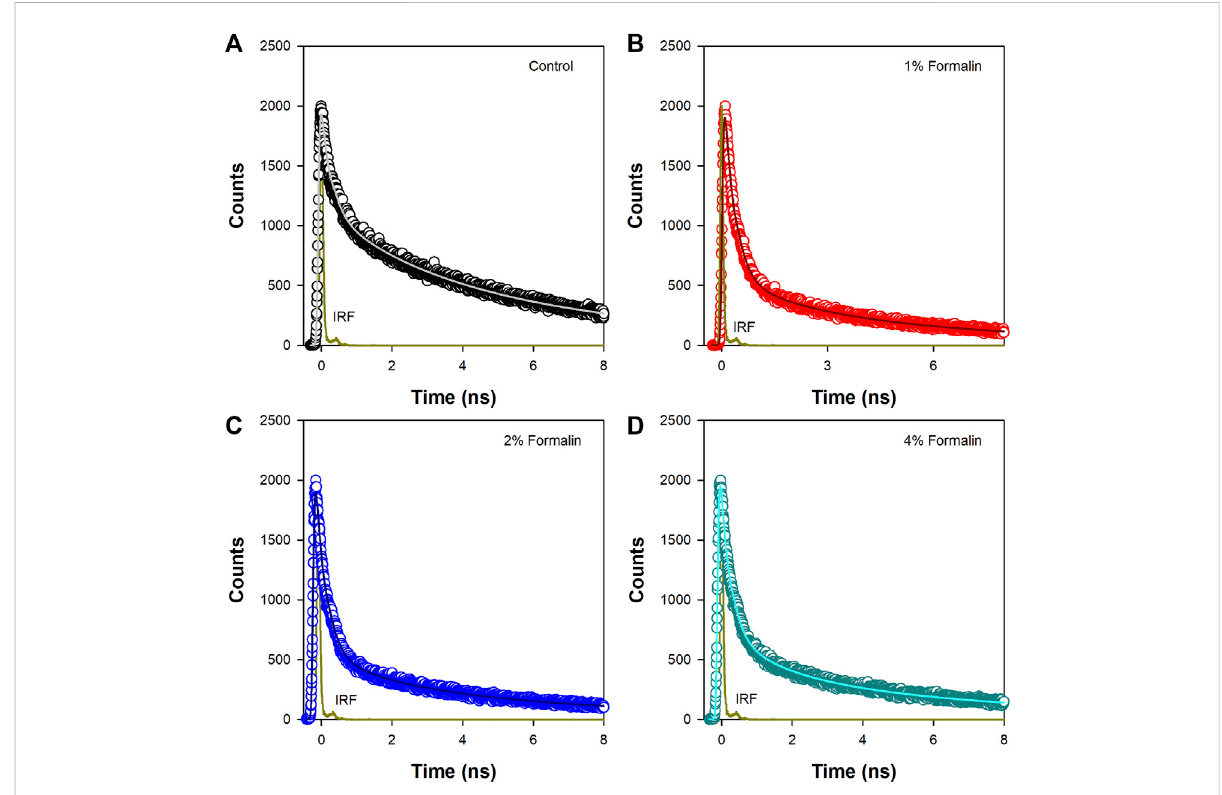
FIGURE 4 Time resolved fl uorescence transients of ANS in (A) Pure CHT (control) and at varying formalin concentrations (B – D) .